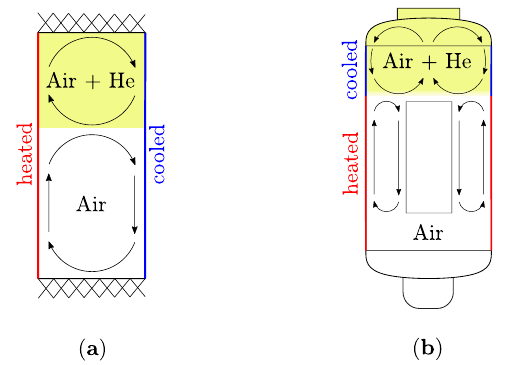
Figure 3. Sketch of the idealized configuration and THAI application case: ( a ) generic test case from the literature with a superimposed mixing process and ( b ) THAI containment with a mixing